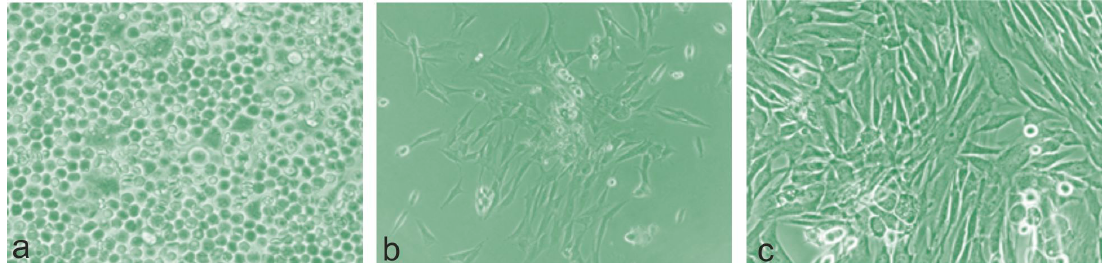
Figure 2. Representative phase contrast micrographs of the evolution of cultured ahMSCs. ( a ) At 3 h; ( b ) 7 days and ( c ) 28 days, adherent ahMSCs practically all displayed a fibroblastic or cuboidal morphology, depending on their confluence (magnification: ×20, ×100 and ×200 respectively).